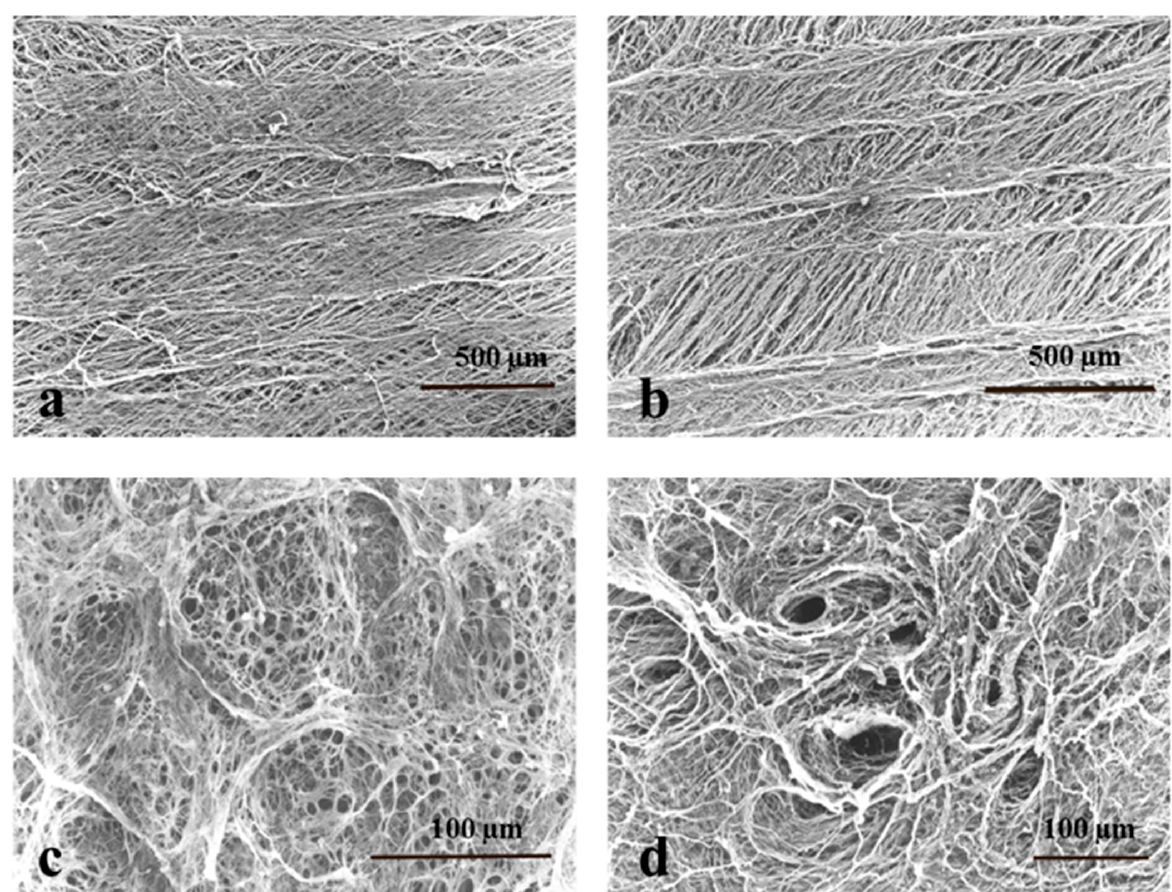
Figure 2. Structures of collagen fibers in Japanese and Chinese hog casings observed using a scanning electron microscope. ( a , b ) External surface of hog casings from Japan and China, respectively. ( c , d ) Internal surface of hog casings from Japan and China, respectively.